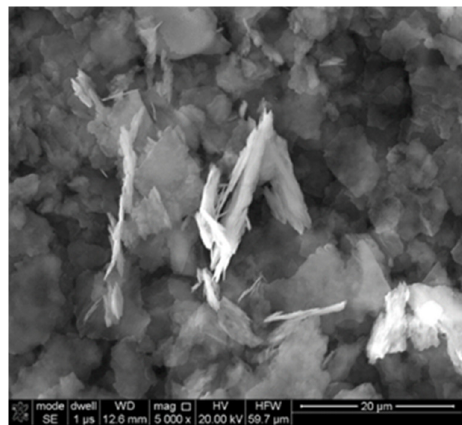
Table 4. Oxygen balances of aluminised compositions.